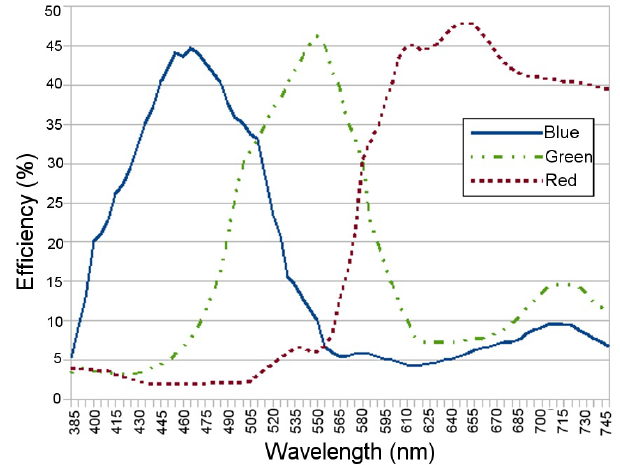
Figure 11. Webcam Bayer Filter Response for Blue, Green and Red respectively data extracted from